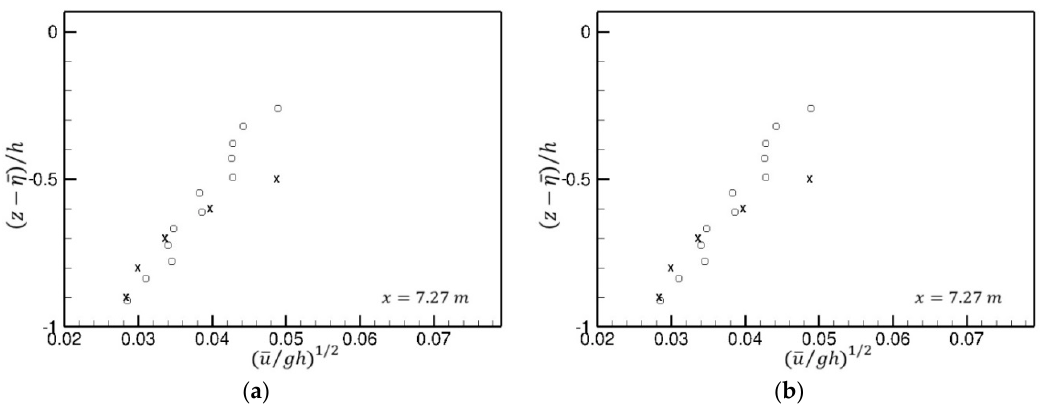
Figure 9. Ting and Kirby [21] spilling breaking wave test case. ( a ) Value of the vertical time-mean cross-shore velocity component at x = 7.27 m; ( b ) value of the turbulent kinetic energy at x = 7.27 m. Comparison between experimental data (empty circles) and numerical results obtained by the proposed modified k − ε turbulence model